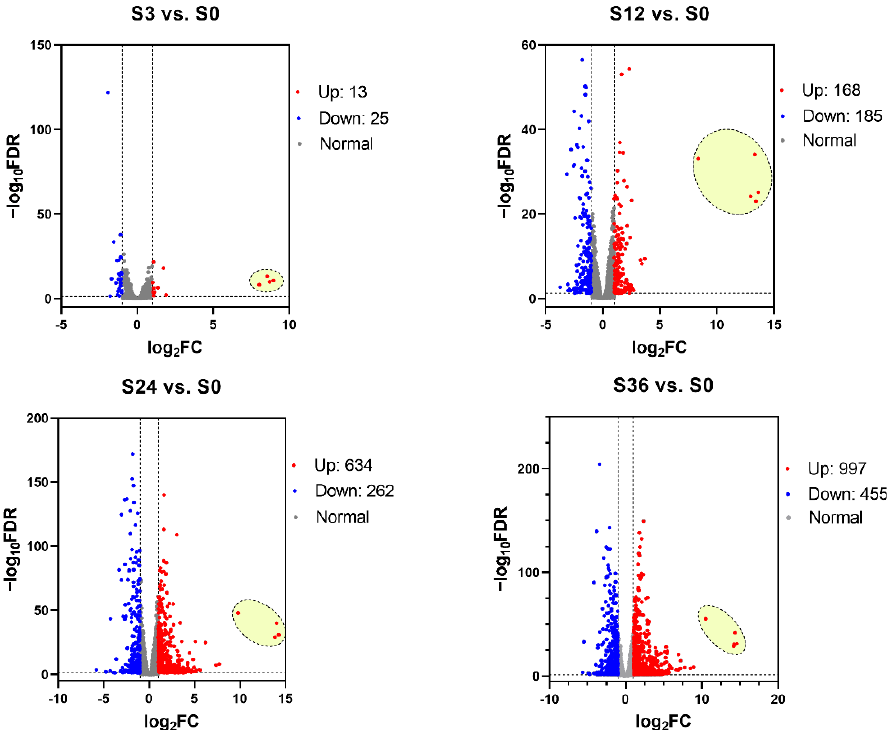
Figure 2. Volcano plots of DEGs in SCRV-infected SCSC cells at different time points. Up- and down-regulated DEGs are indicated by red or blue, respectively, and gray color indicates unchanged DEGs. The red plots that were boxed by yellow ellipse indicate SCRV genes.